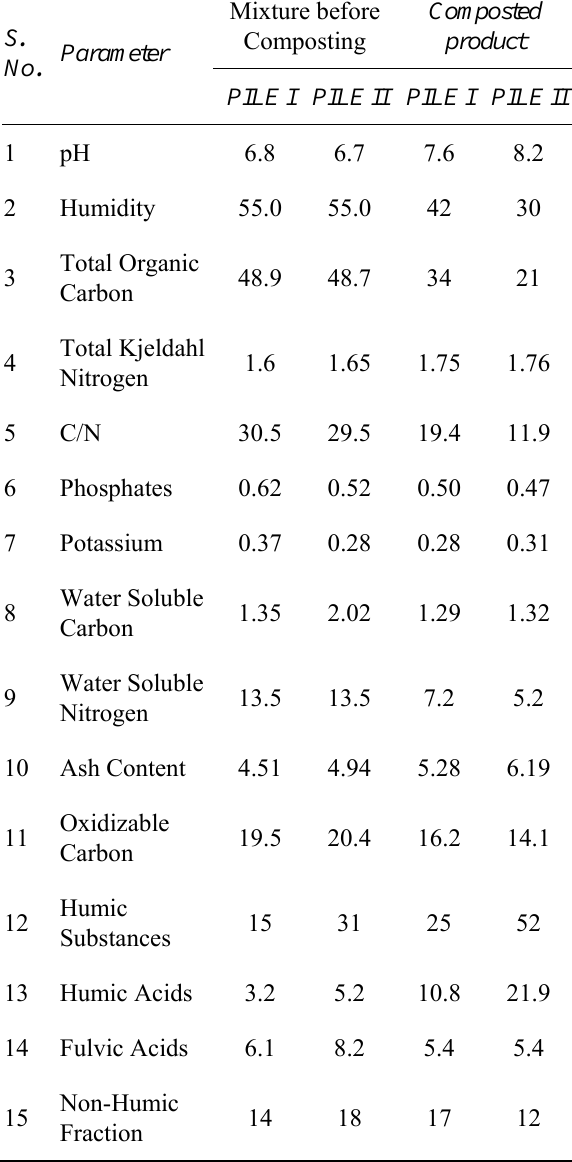
Table 3: Compost Product